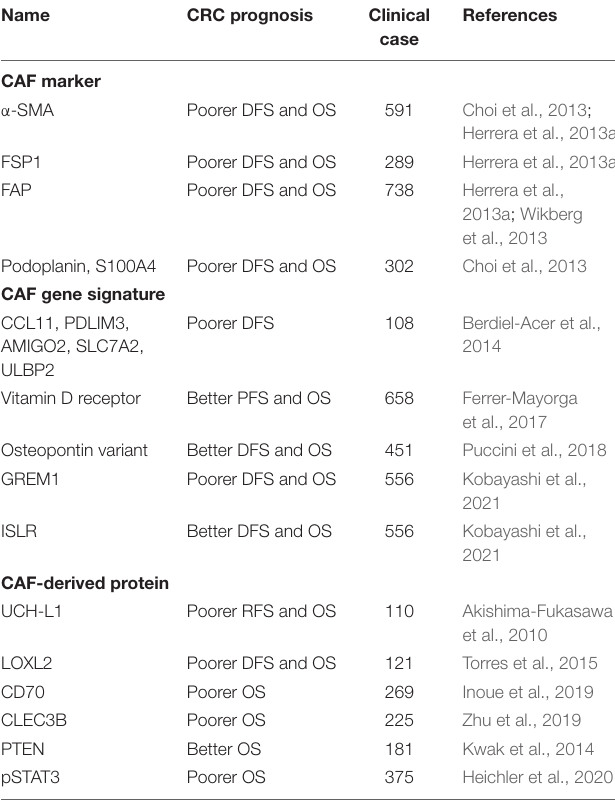
TABLE 3 | Prognostic impact of CAFs in CRC